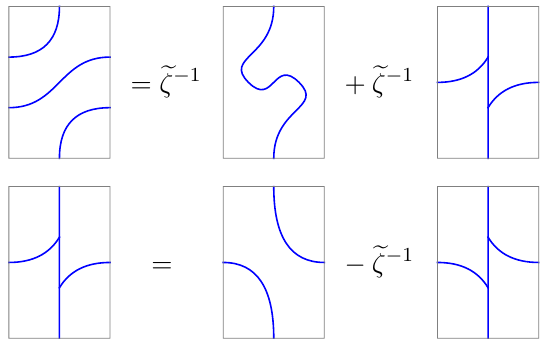
Figure 37 . Applying the H-junction crossing relations to the T 2 transformation of W line in time